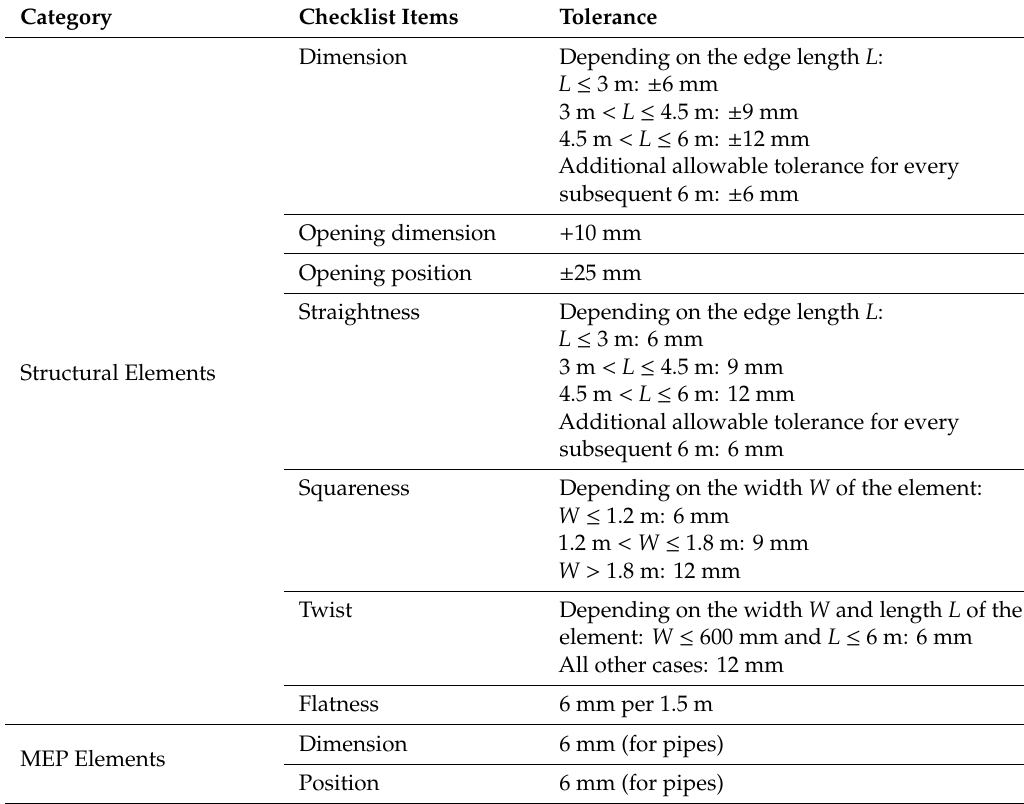
Table 1. Geometric quality inspection checklist and tolerance of prefabricated housing units.